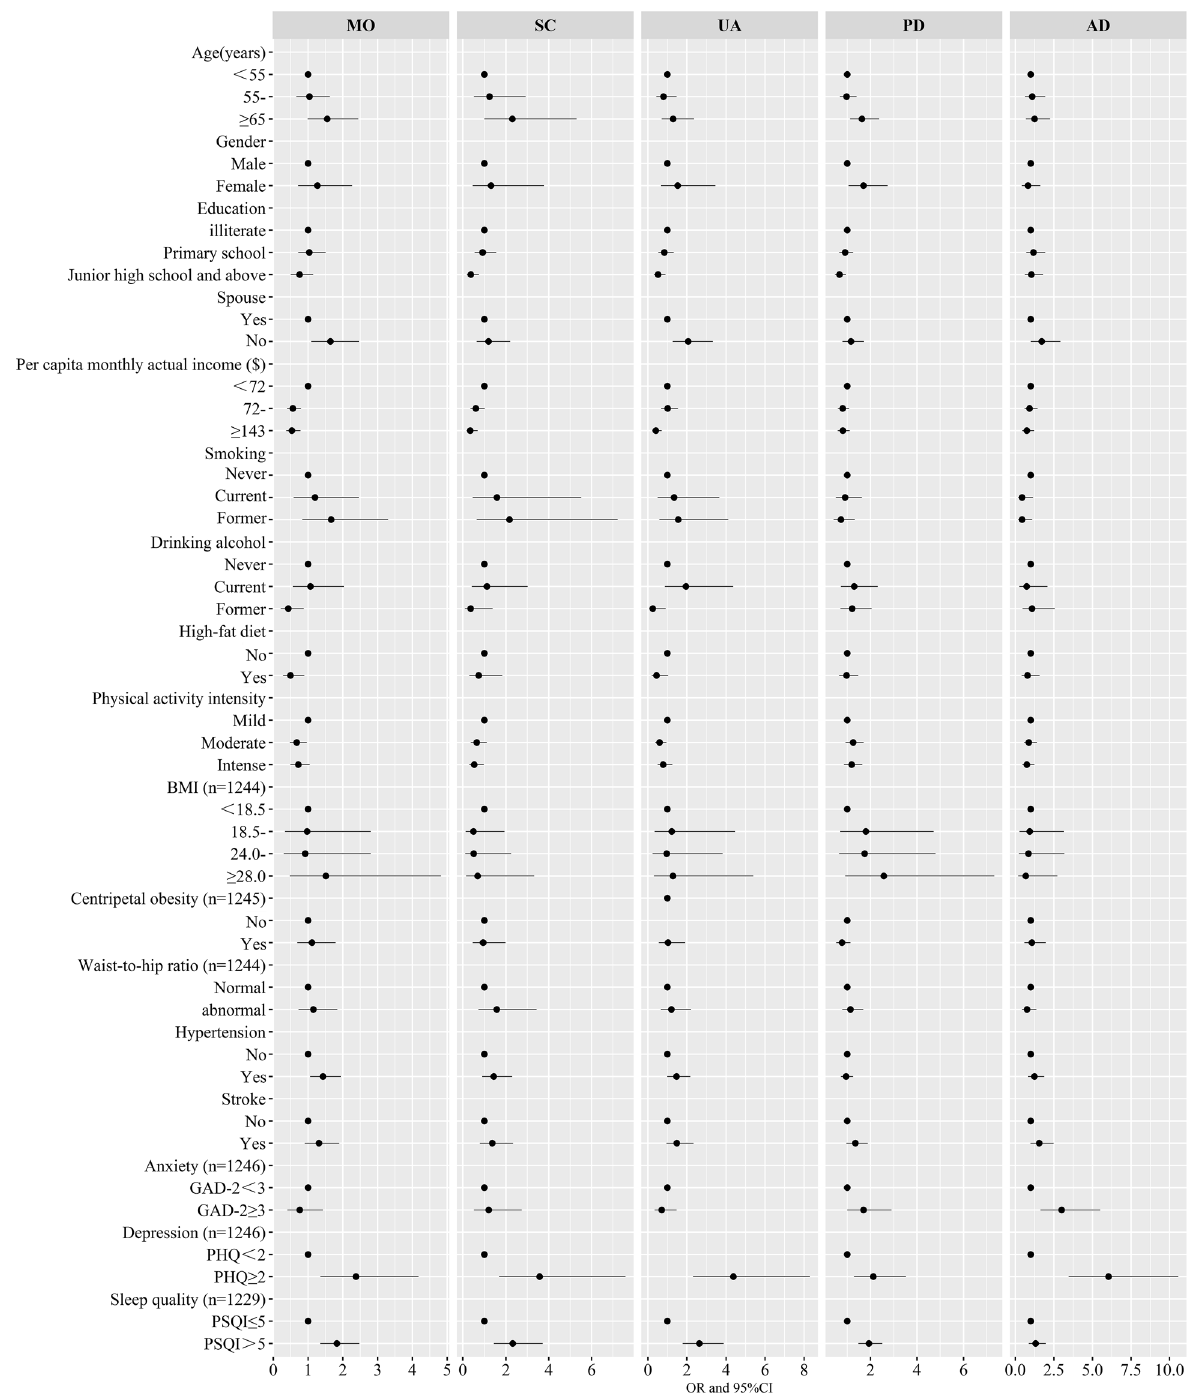
Figure 1. Risk factors for having problems in each EQ-5D dimension [Mobility (MO), Self-care (SC), Usual activities (UA), Pain/discomfort (PD) and Anxiety/depression (AD)] among patients with coronary heart disease (n = 1247) were analyzed by binary logistic regressions. The black dots with the corresponding error bars represented the estimated effect and 95% confidence intervals of the change in each of variables. A two-sided P value 0.05 was considered statistically significant. Notes : GAD-2 Generalized Anxiety Disorder Scale-2, PHQ-2 Patient Health Questionnaire-2, PSQI the Pittsburgh Sleep Quality